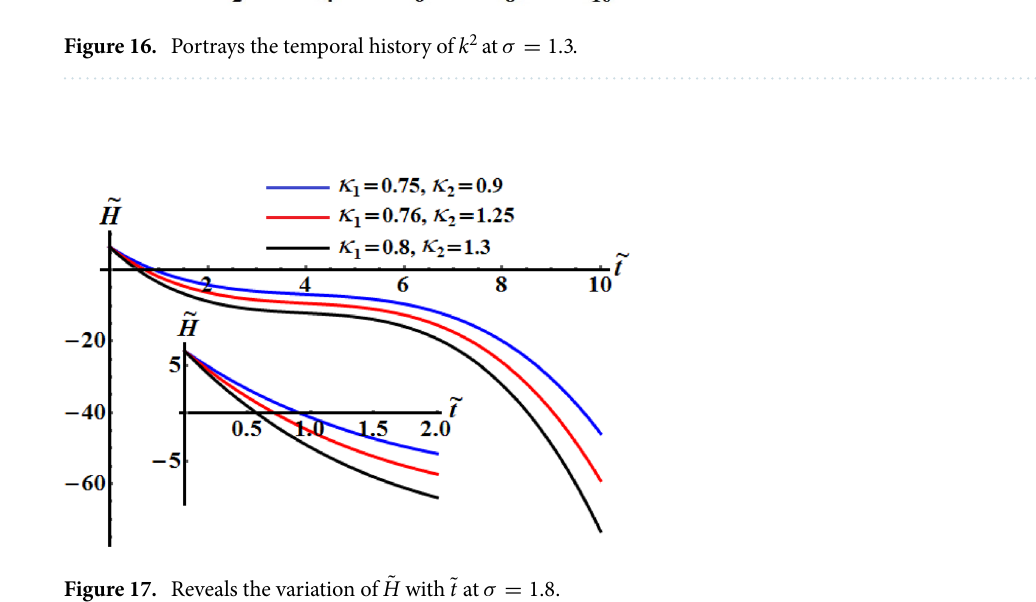
Figure 17. Reveals the variation of ˜ H with ˜ t at σ =